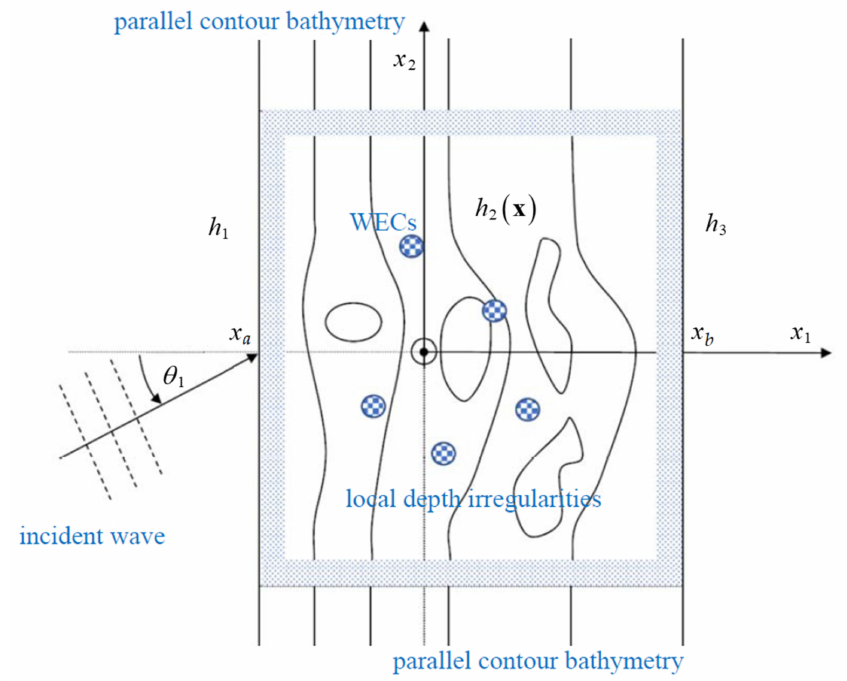
Figure 2. Implementation of the MMSE solution with PML absorbing scheme (shaded zone) sur- rounding the computational